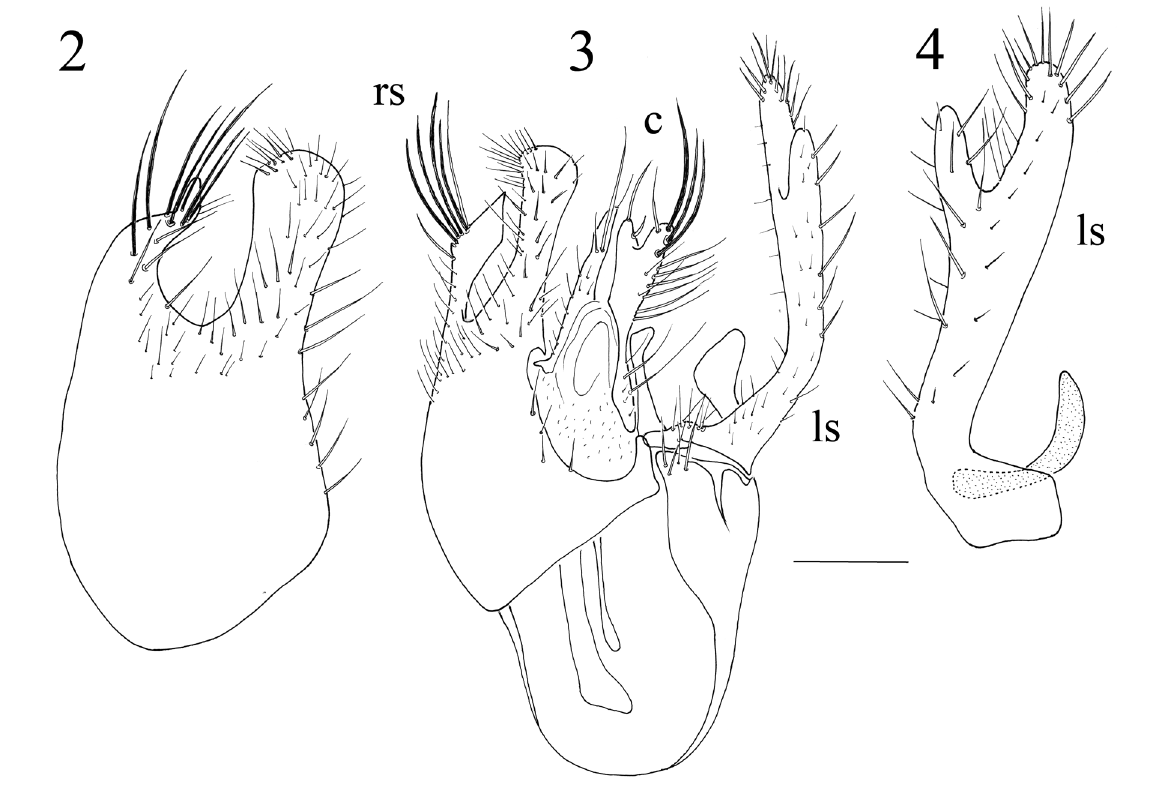
Figs 2–4. Elaphropeza triseta sp. nov. Male terminalia. 2 . Right epandrial lamella. 3 . Epandrium with cerci. 4 . Left surstylus. c = cerci; ls = left surstylus; rs = right surstylus. Scale bar = 0.1